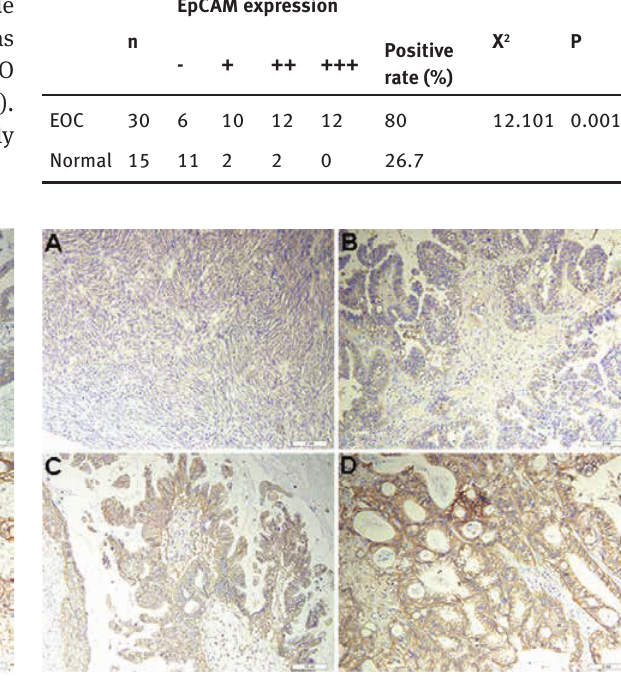
Figure 2: Representative immunohistochemical results of EGFR in human normal ovary and epithelial ovarian carcinoma tissue sections. (A) Mild staining of EGFR in normal ovary tissue. (B) Epithelia ovarian carcinoma tissue with weak positive (+) of EGFR. (C) Epithelia ovarian carcinoma tissue with moderate positive (++) of EGFR. (D) Epithelia ovarian carcinoma tissue with strong positive (+++) of EGFR